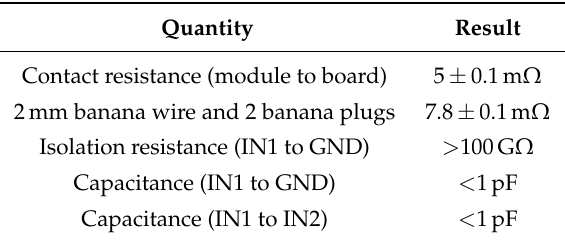
Table 3. Overview of parasitic effects of the modular micro-power